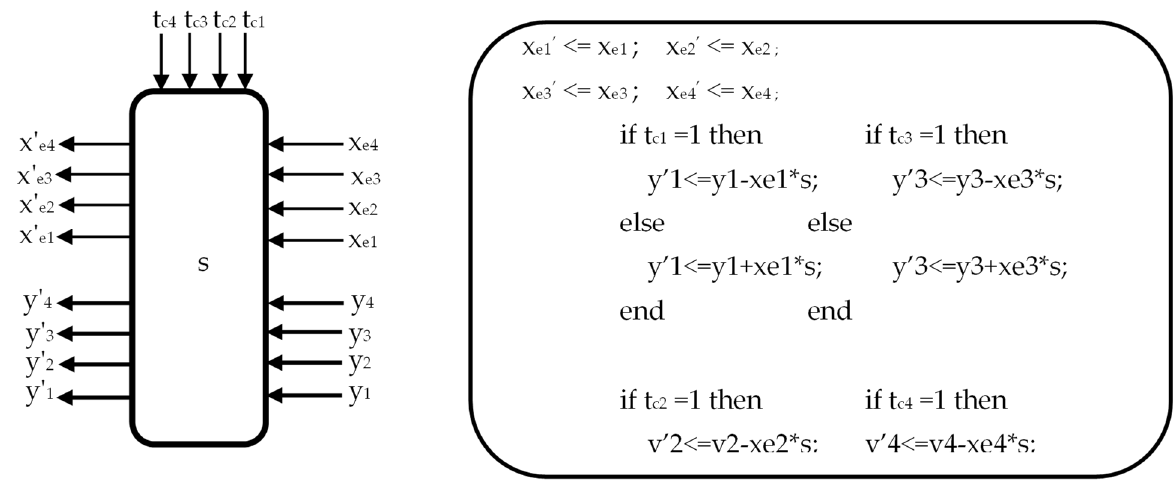
Figure 3. The function of the processing elements from Figure 2.